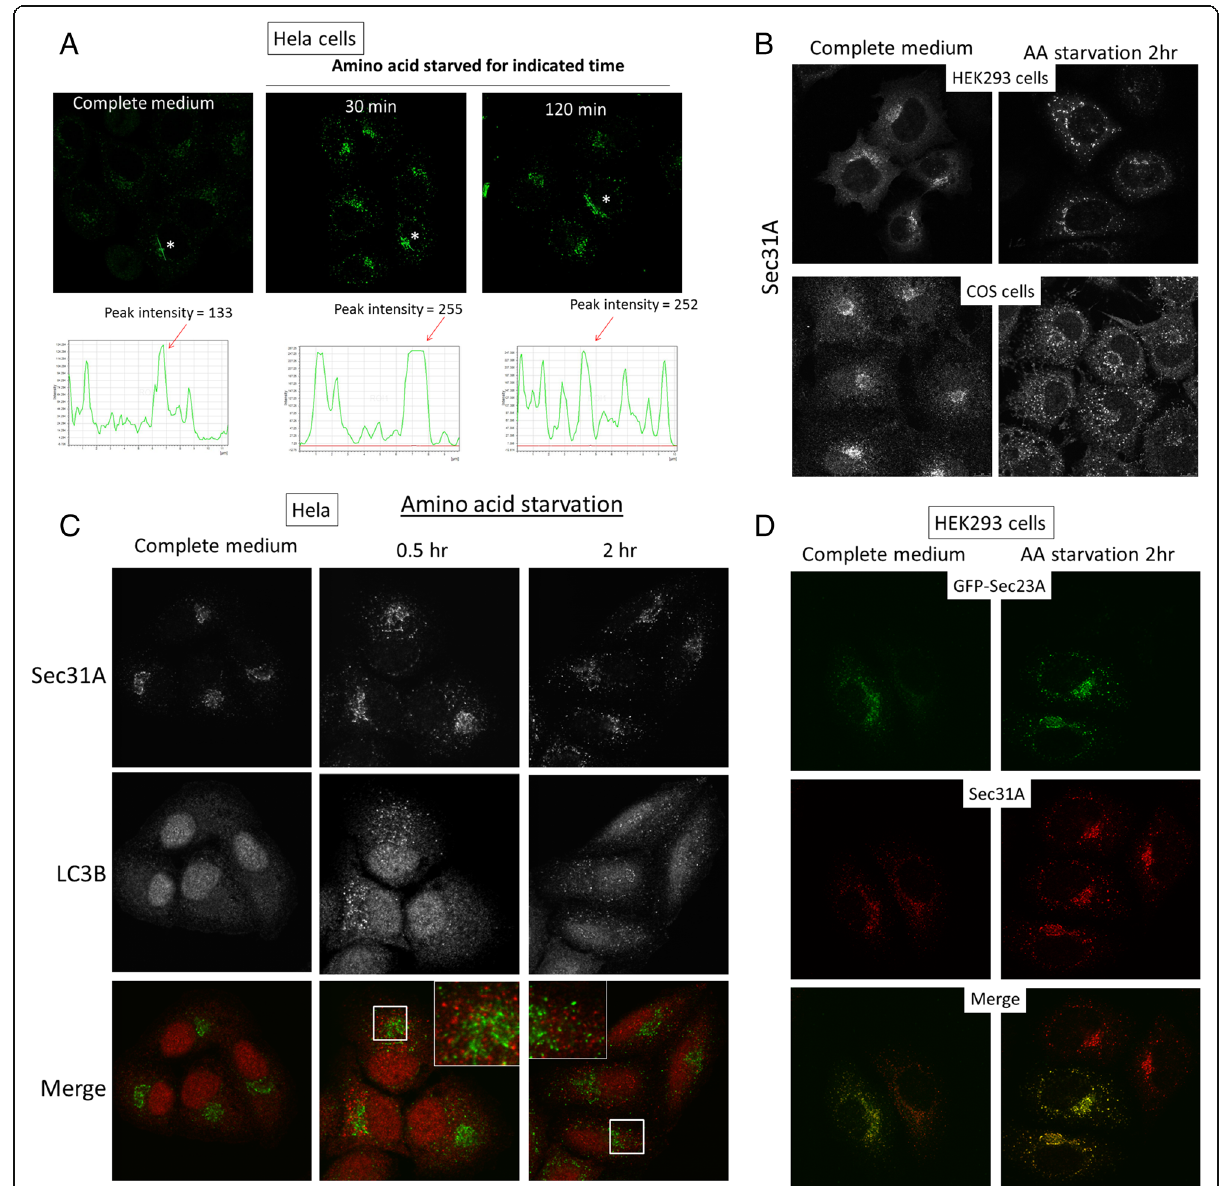
Fig. 2 Autophagy changes the morphology of ERES. a Hela cells were cultured in growth medium or amino acid starved in EBSS to activate autophagy for indicated time. Cells were stained with ERES by anti-Sec31A antibody. Fluorescence intensity profiles of the ERES of the cells marked with asterisks were quantified. A line was drawn from a cell chosen in the image to generate fluorescence pixel intensity. b ERES in HEK293 (top) and COS cells ( bottom ) in complete growth medium or in EBSS (AA starvation). c Hela cells incubated with complete medium or EBSS for amino acid starvation for 0.5 or 2 h were stained with ERES (Sec31A, green in merge) and autophagosomes (LC3B, red in merge). d HEK293 cells were transfected with GFP-Sec23A ( green ). Transfected cells were cultured in growth medium or EBSS for 2 h before fixation and staining with Sec31A ( red